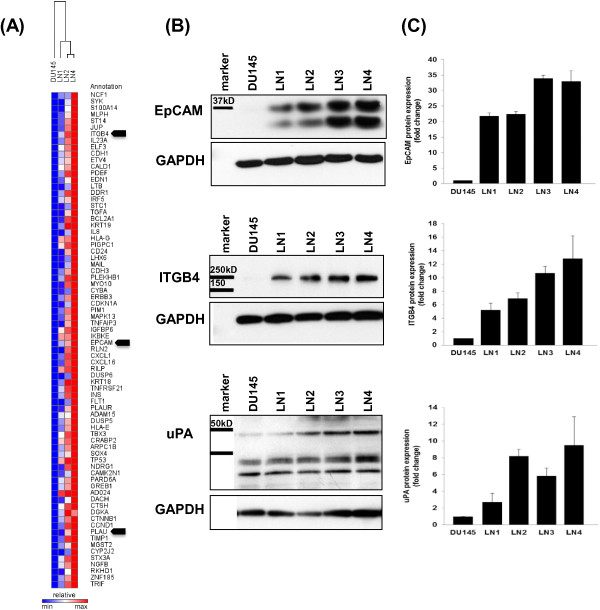
Gene expression analysis in the DU145-LN metastatic sublines and validation of increased EpCAM, integrin β4 and uPA protein expression. (A) Heat map of cell-movement and cancer genes increased in the more metastatic DU145-LN sublines, relative to DU145 cells. Relative expression color scale from high (red) to low (blue). Arrowheads indicate genes selected for further analysis. (B) Western blot analysis of EpCAM, integrin β4 and uPA expression in whole cell lysate showed progressive increase in expression in the DU145-LN metastatic sublines. 20 μg protein was loaded to detect EpCAM, 70 μg protein was used for integrin β4 and uPA western blots. GAPDH shown as protein loading controls. (C) Band intensity for each protein was evaluated using ImageJ software and averaged from 2–4 western blots each.